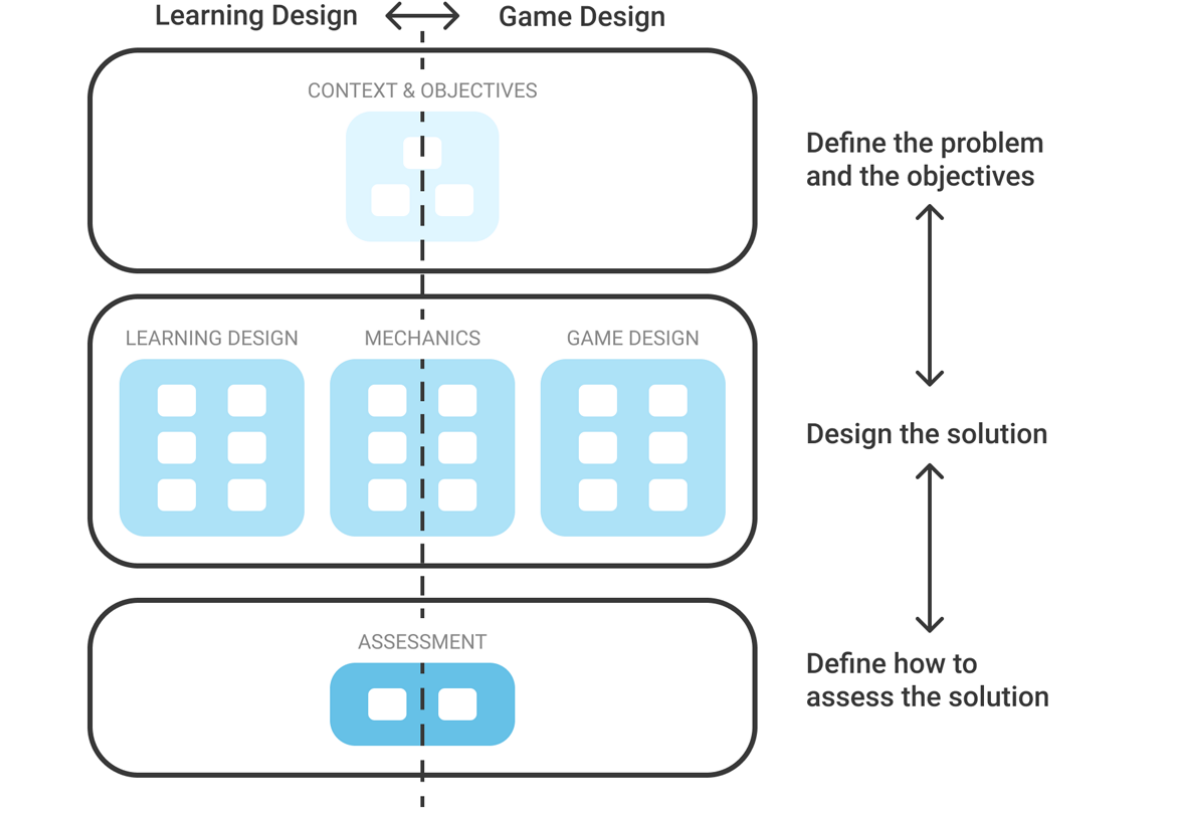
Figure 2. Structured vision of the 5 serious game design